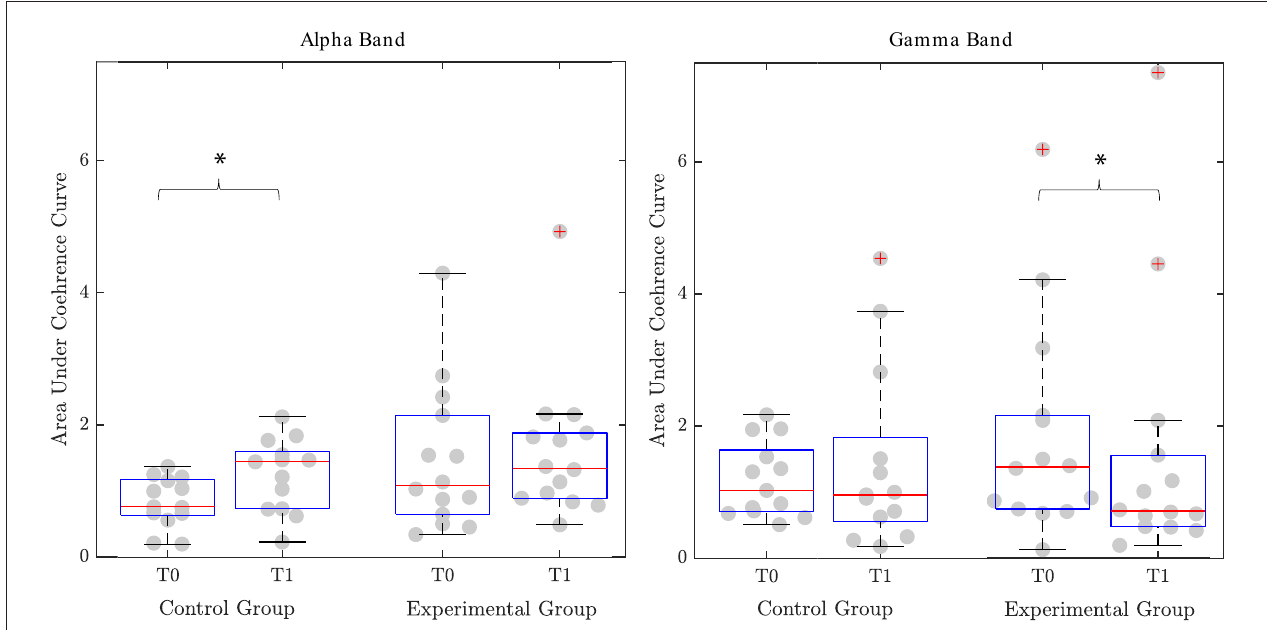
FIGURE 3 | Area under the coherence curve for the couple of proximal agonist-antagonist muscles (Rectus Femoris-Semitendinosus). Significant differences ( p -value < 0.05) are reported with *. T0, Assessment before the intervention; T1, Assessment after the intervention.